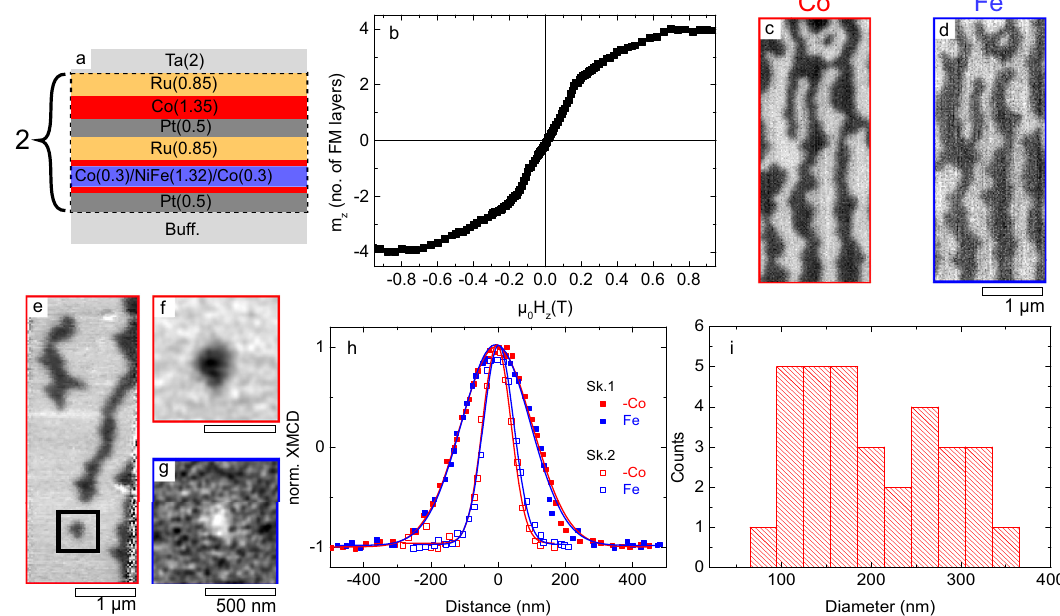
Fig. 1 | Observation of SAF skyrmions.a Material stack for the SAF. Buff. denotes Ta(3)/Pt(2.5)(thicknessesinnanometres). b Out-of-planehysteresisloopmeasured by vibrating sample magnetometry. m z denotes the reduced out-of-plane compo- nent of the magnetisation. c , d X-ray magnetic circular dichroism scanning trans- mission X-ray microscopy (XMCD-STXM) images acquired at c the Co L 3 and d the Fe L 3 absorptionedgesafterout-of-planedemagnetisation.Anisolatedskyrmionis observed at the top of the image (Sk.2). e XMCD-STXM image acquired at the Co edge showing an isolated skyrmion (Sk.1). The image was recorded at zero fi eld